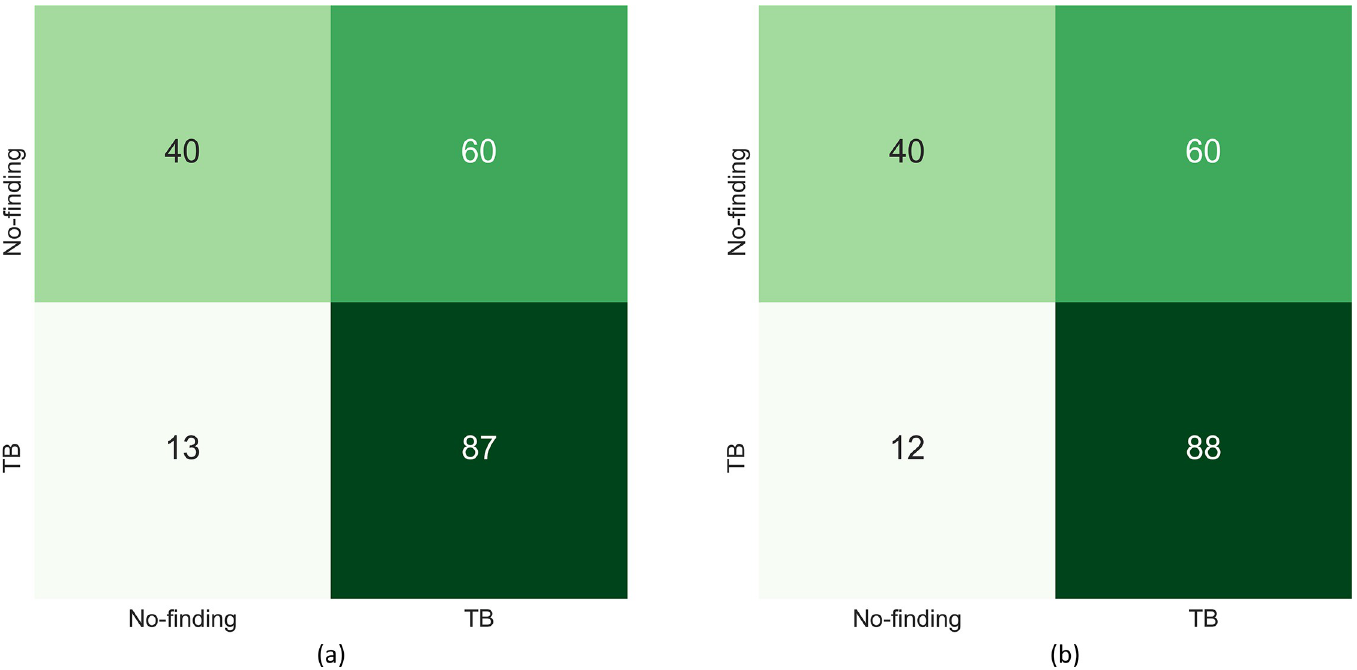
Fig 11. Confusion matrices obtained with the uncalibrated and calibrated probabilities (from left to right) at their optimal thresholds derived from the PR curves (refer to Table 6) using the Set-20 dataset constructed from the Shenzhen TB CXR dataset.